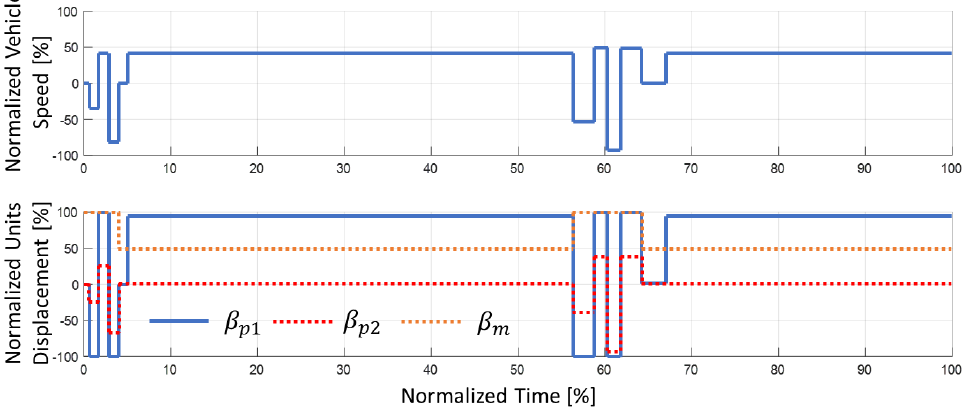
Figure 19. Simulation results (Solution A).